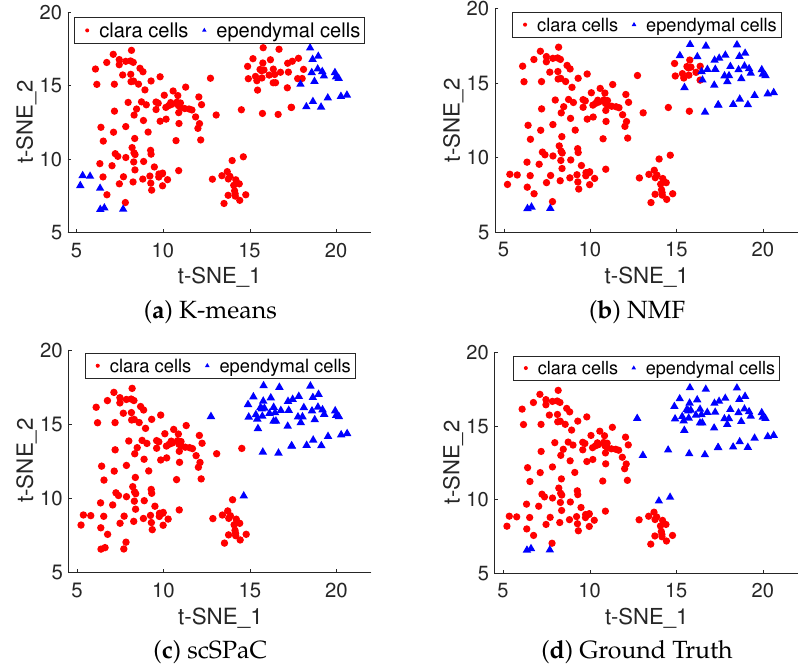
Figure 4. t-SNE for pulmonary alveolar type II, clara and ependymal cells of human scRNA-seq data cluster results. The red filled circles represent clara cells and the blue filled triangles represent ependymal cells. ( a ) t-SNE for K-means; ( b ) t-SNE for origin NMF; ( c ) t-SNE for single cell self-paced clustering (scSPaC); ( d ) t-SNE for ground